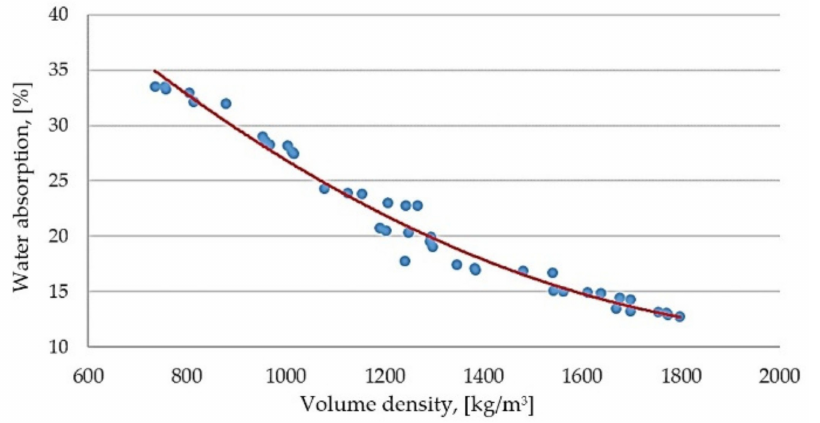
Figure 3. Dependence of water absorption on the volume density of modified samples with the fraction GFG of 0.25–0.5 mm.